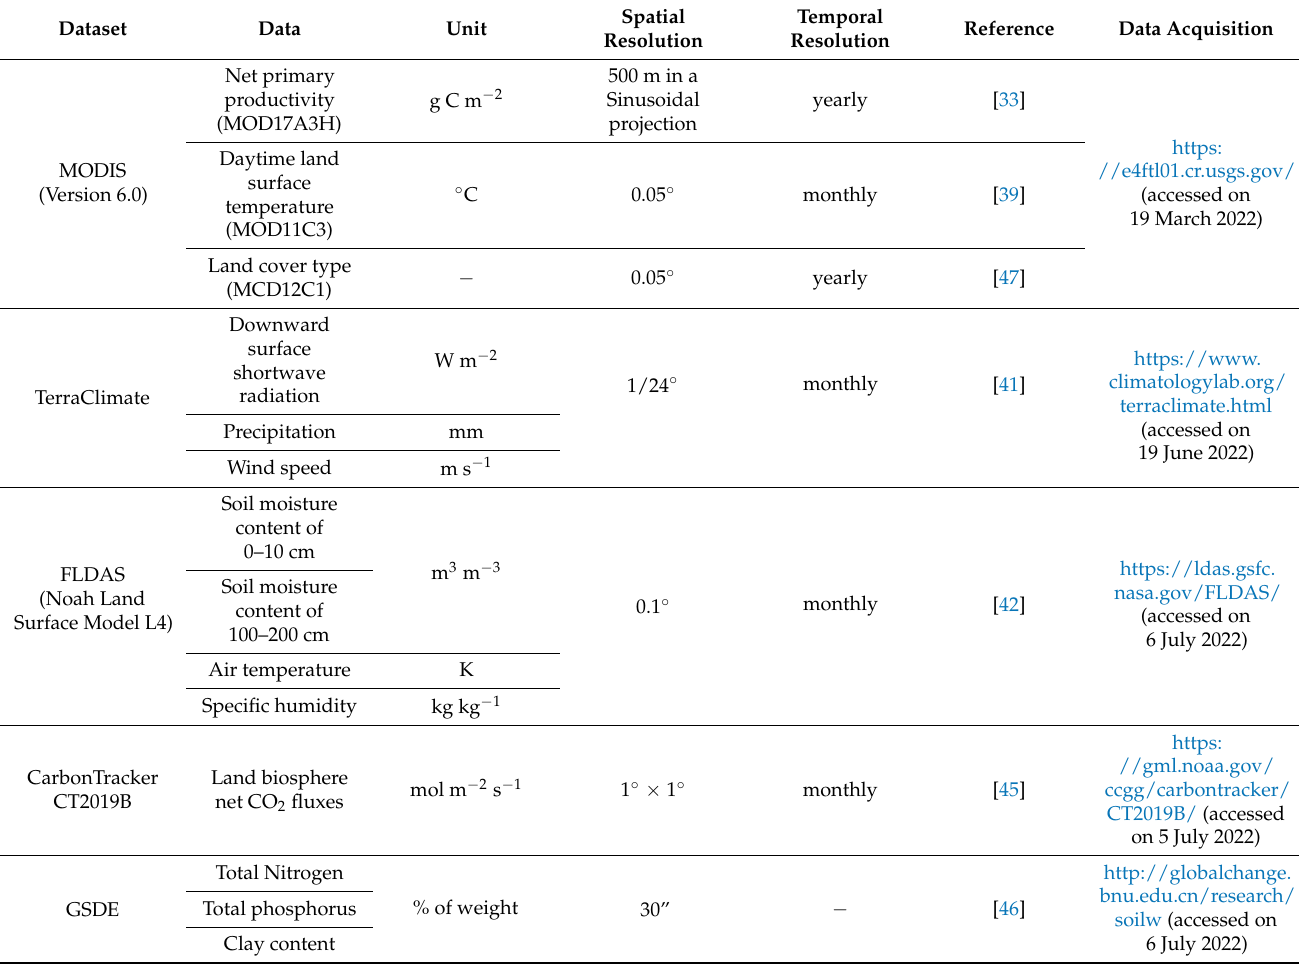
Table 1. Summary of data products used in this